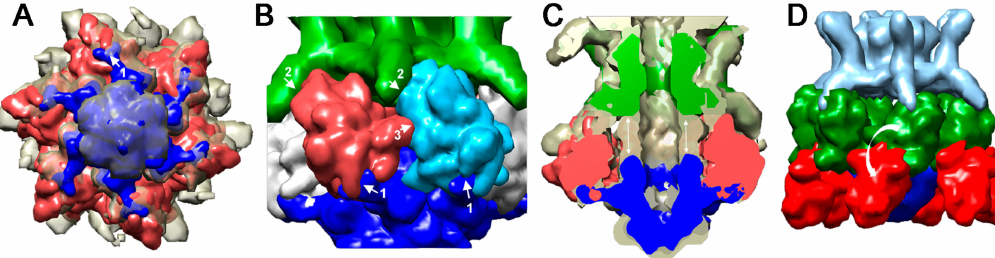
Figure 7. Structure of the activatable baseplates from siphophage 1358 [25]. ( A ) The nsEM structure of the non-activated baseplate viewed from the phage bottom. Tal and Dit are colored blue. The RBP is colored red. Note the "arm and hand" of Dits interacting with base of the RBPs (white arrow). ( B ) Lateral view of the baseplate showing the interactions of the Dit with the RBP N-terminal domain (shoulders) (1), the interaction of the MTP lateral extension with the RBP head domain (2) and lateral RBP contacts (3). ( C ) Sliced lateral view of the baseplate showing the non-assigned volume that can be attributed to a second Dit hexamer (white arrows). Tal and Dit are colored blue, RBP red, and MTPs green. ( D ) Lateral view of the nsEM maps of the baseplate in the non-activated state (green) and the activated state (red) resulting from a rotation of the RBPs attached to the Dits arms and